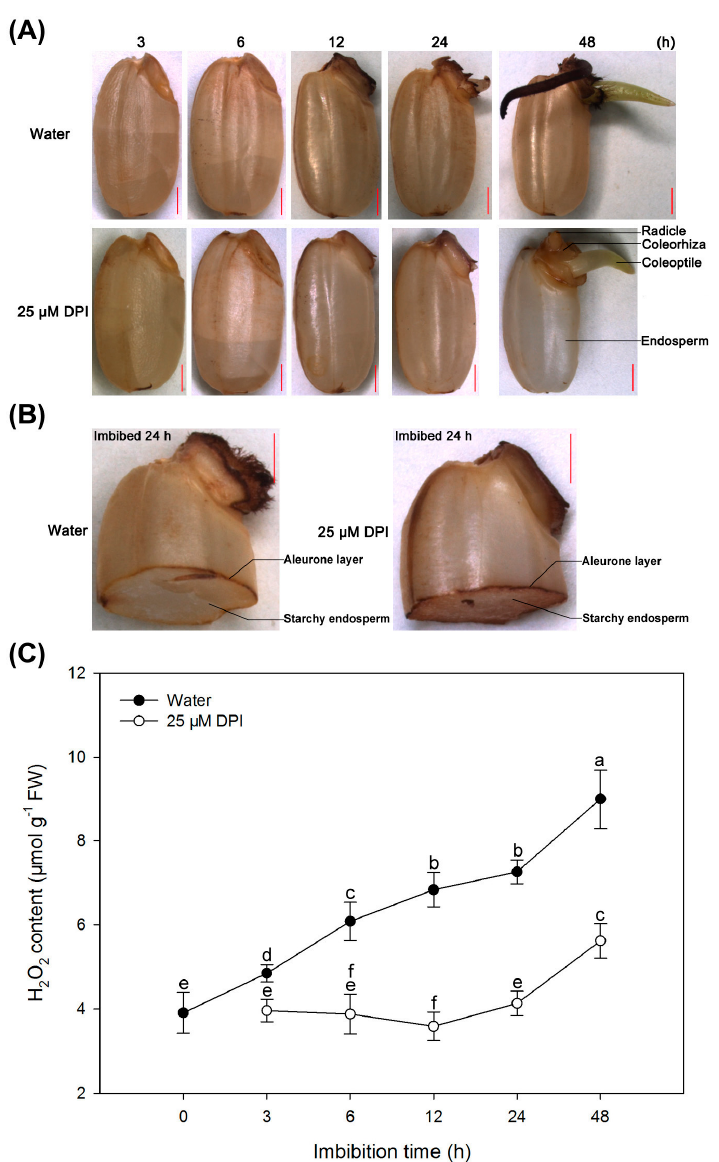
Figure 4. Histochemical staining and quantification of H 2 O 2 in rice seeds in water or with DPI. ( A , B ) Histochemical staining with DAB to determine the localization of H 2 O 2 in whole seeds incubated in water or with 25 μ M DPI for 3, 6, 12, 24, 48 h and half granule seeds with embryo for 24 h, respectively. Scale bar, 1000 μ m; ( C ) Quantification of H 2 O 2 content in rice seeds incubated in water or with 25 μ M DPI for 0, 3, 6, 12, 24 or 48 h. Data represent the mean ± SE of three biological replicates of 30 embryos (~0.1 g) each. Means denoted by the same letter do not significantly differ at p < 0.05 (Fisher’s least significant difference test). FW, fresh weight.